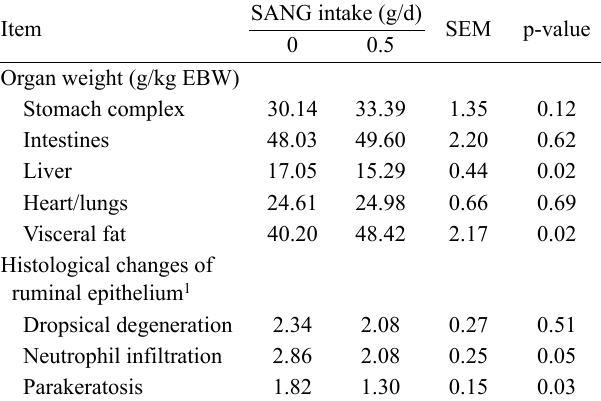
Table 5. Effects of Sangrovit-RS supplementation (0.5